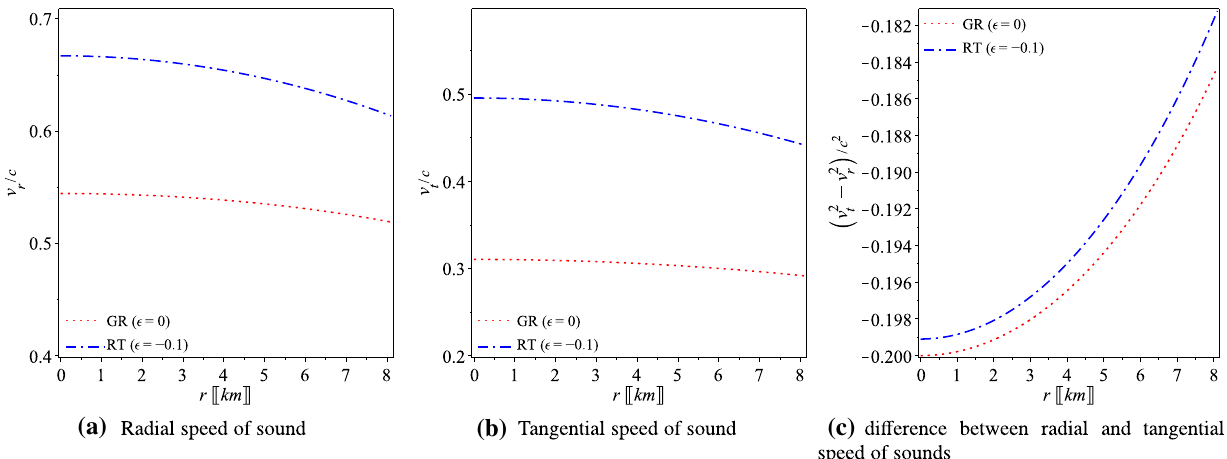
Fig. 3 The radial and tangential sound speeds (30) versus the radial coordinate r in km for the pulsar Her X-1 . The plots confirm that the model fulfill the causality and the stability conditions (viii) and (ix) in Sect. 4